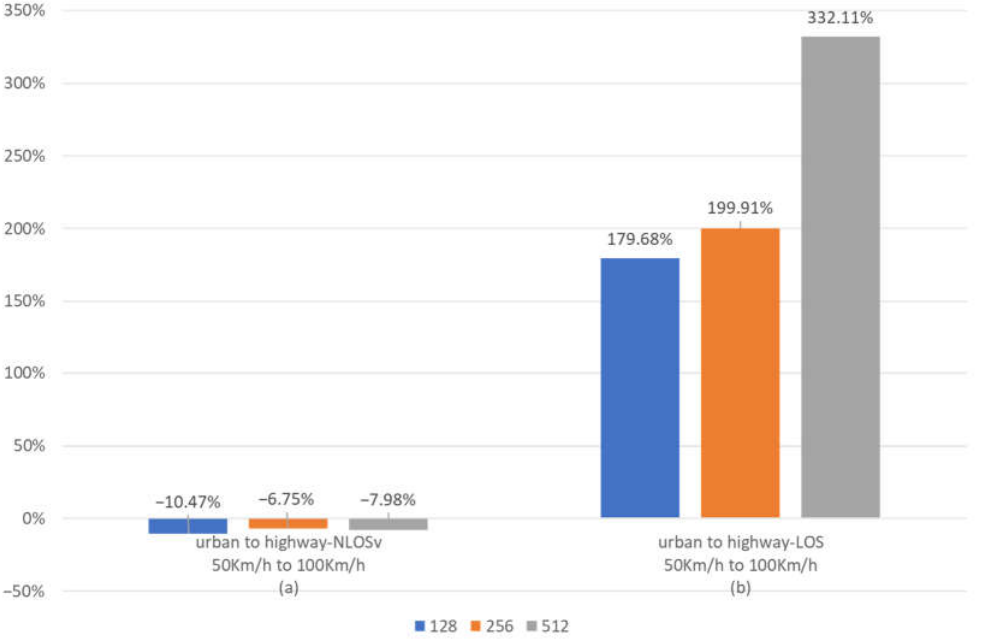
Figure 6. Mean percentage BER improvement when the velocity (traffic model) changes for maxlog- BCJR and for 128-, 256- and 256-bit frames. ( a ) BER improvement for velocity change from 50 to 100 Km/h having NLOSv channel state. ( b ) BER improvement for velocity change from 50 to 100 Km/h having LOS channel state.